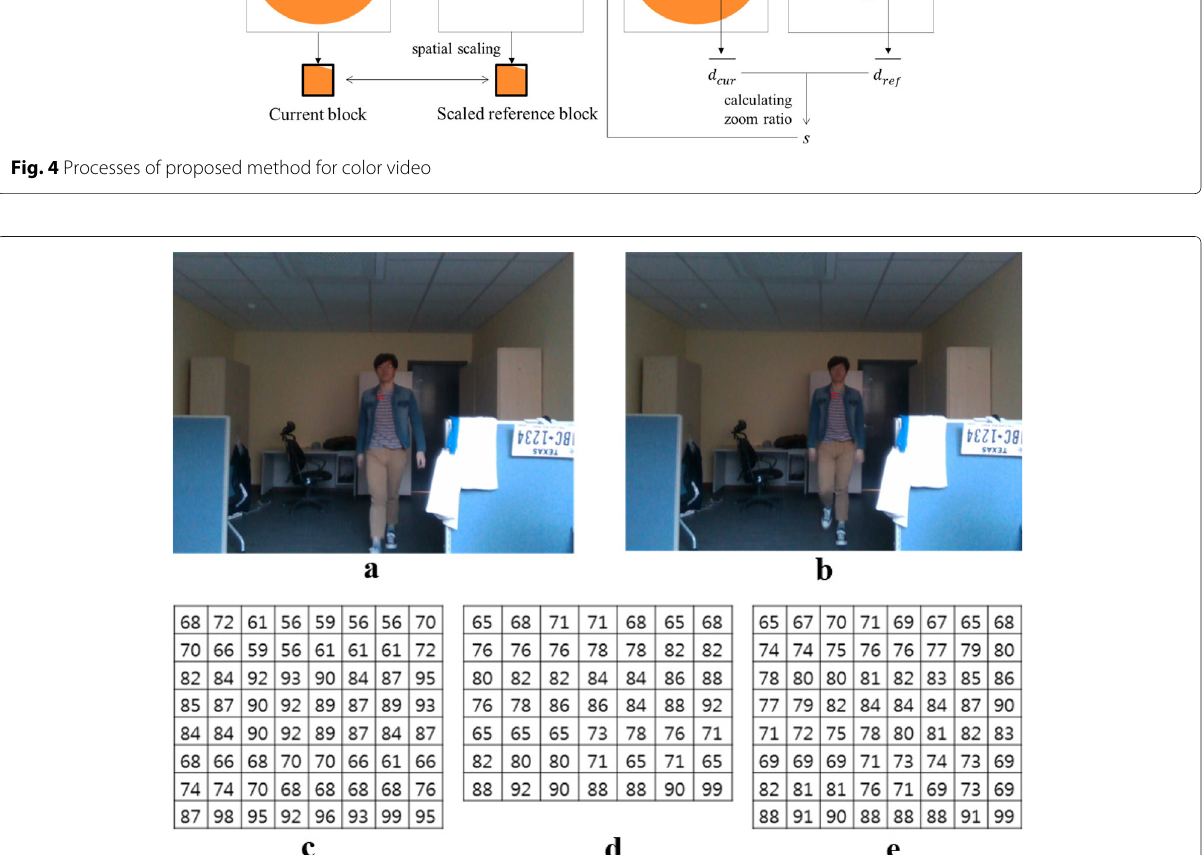
Fig. 5 Zoom motion estimation for color video. a Current picture, b reference picture, c current block, d 7 × 7 reference block, and e size-scaled reference block